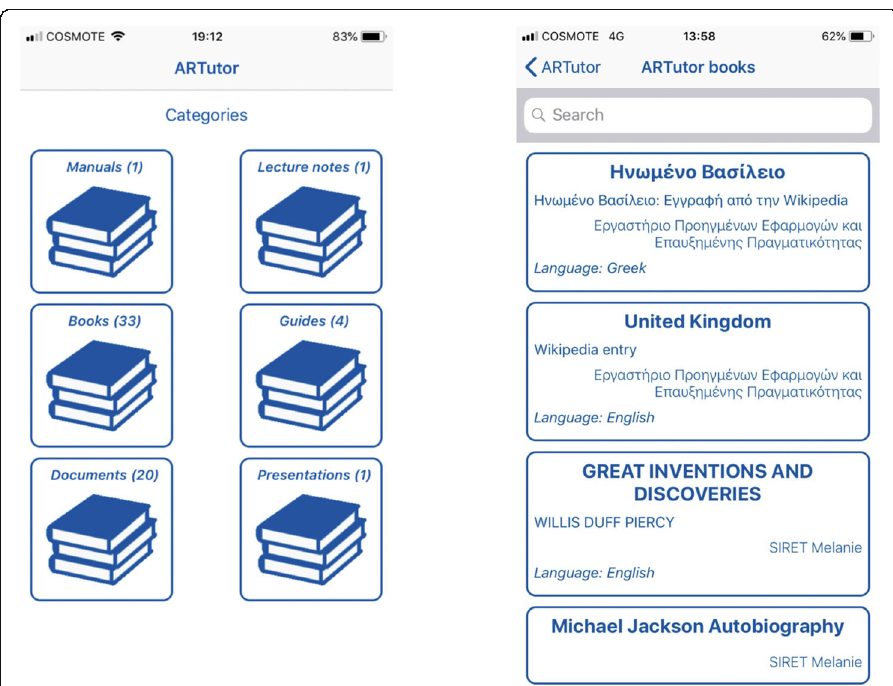
Fig. 3 The ARTutor mobile application user